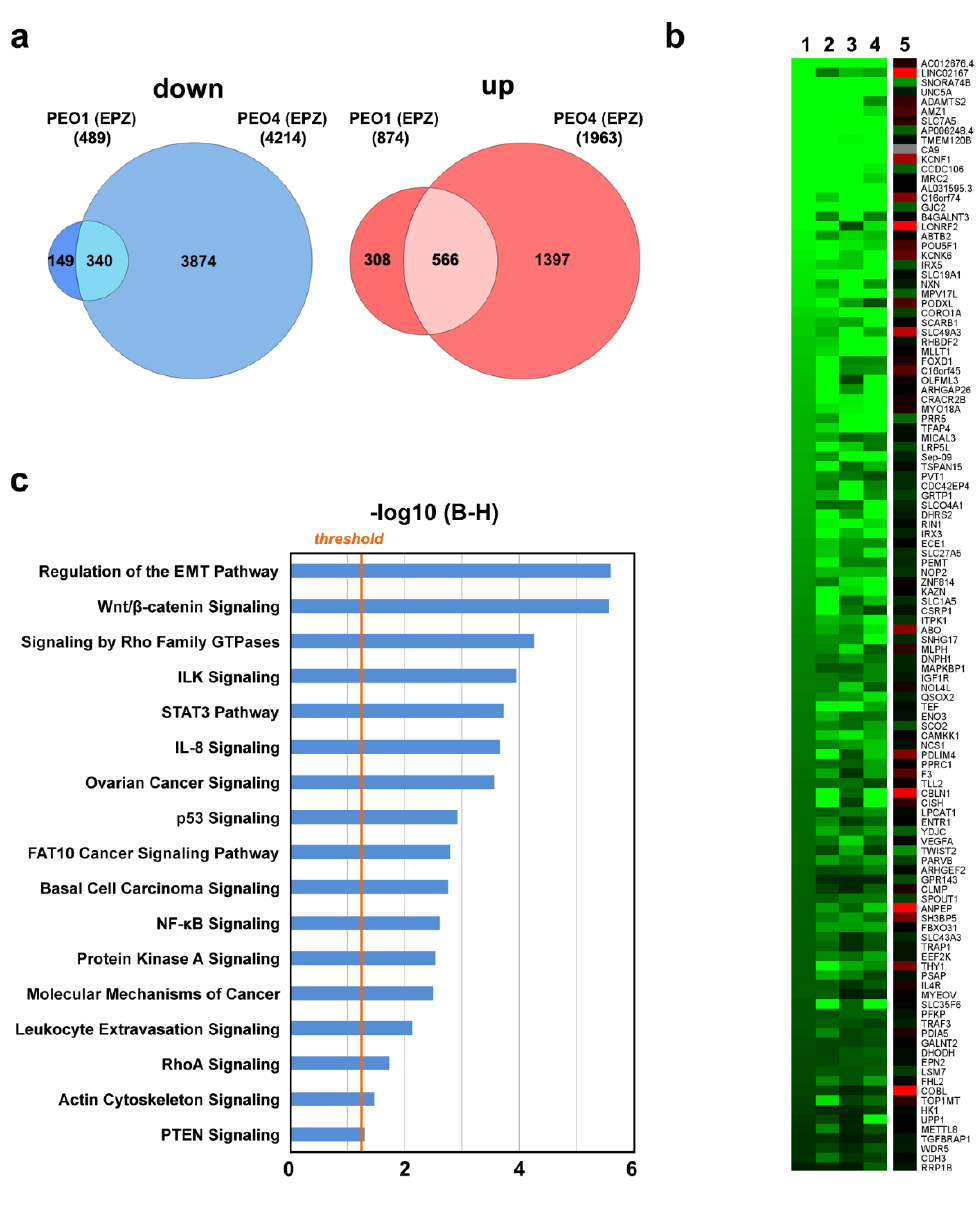
Figure 4. E ff ects of DOT1L pharmacological inhibition on OC cell transcriptome. ( a ) Venn diagrams showing down- (left) and up- (right) regulated transcripts after EPZ (6.4 µ M) treatment in both PEO1 and PEO4 cells. RNA-Seq was performed in biological triplicates. ( b ) The heatmap showing transcripts regulated by both ICI (100 nM) or EPZ (EPZ, 6.4 µ M) in both PEO1 and PEO4 cells, compared to EPZ-treated ER α -negative PEO14 cells. ( c ) Graphic representation of statistically significant pathways, identified by IPA analysis, considering genes responding to DOT1L and ER α inhibition with EPZ and ICI, respectively, in PEO1 and PEO4, but not PEO14, cells. The straight orange line marks the Benjamini Hochberg p -value (B–H) threshold